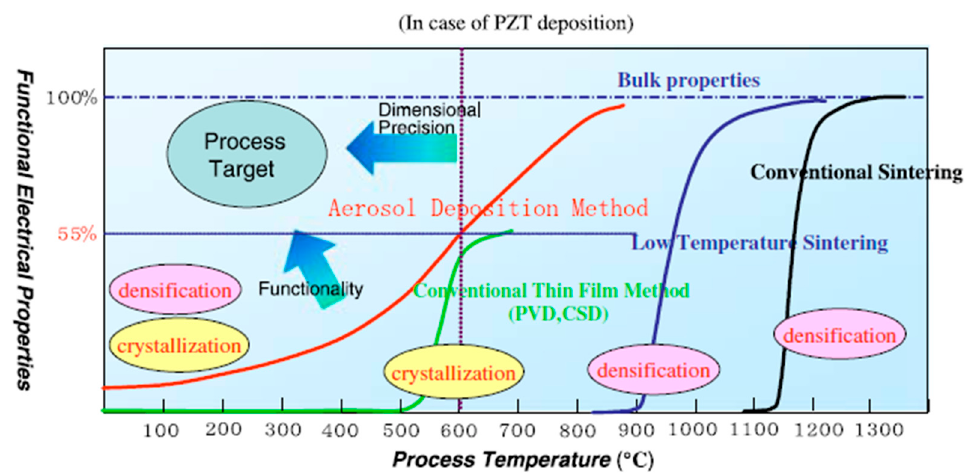
Figure 3. Improvement in the functional properties of ferroelectric aerosol deposition (AD) films by heat treatment [2]. © Copyright 2008, J. Therm. Spray Technol.